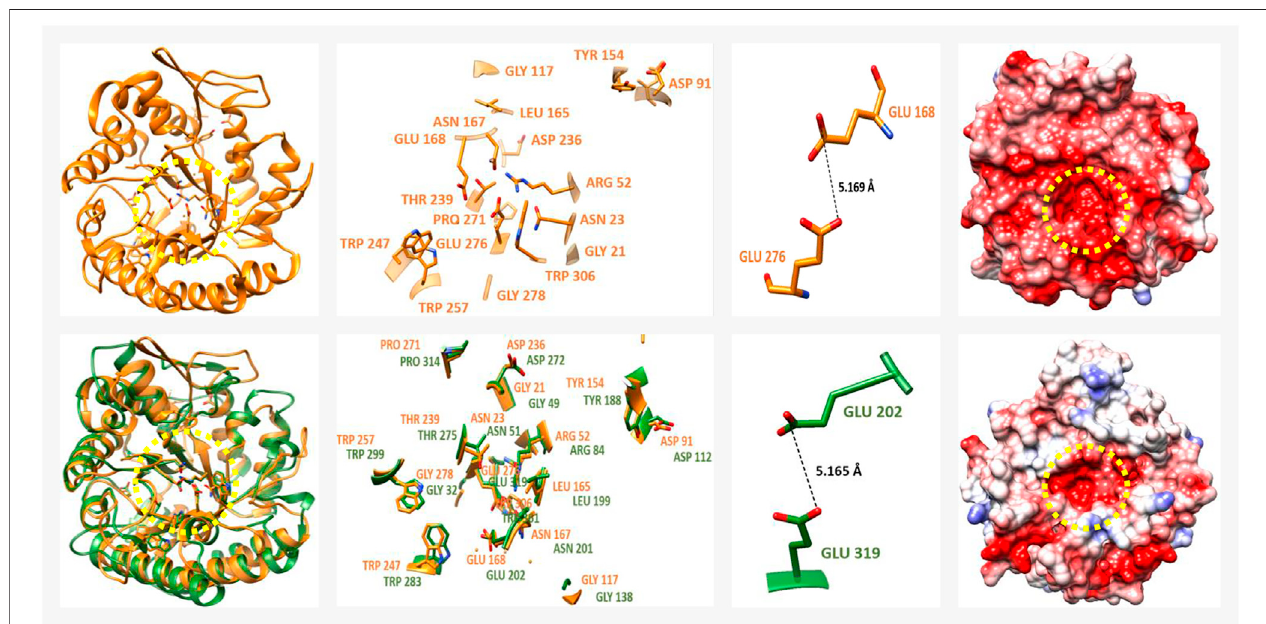
FIGURE 8 | 3D structure from an endo- β -1,4-mannanase (E β M-1,4) from Psittacanthus schiedeanus (enzyme member of GH5-7 family). From top to bottom, the E β M-1,4 from the phytopathogenic fungus Aspergillus niger BK01 (reference protein, PDB ID: 3WH9) followed by one of the modelled E β M-1,4 of the mistletoe P. schiedeanus . The E β M-1,4 from P. schiedeanus (UN045719, cyan) was superimposed with reference protein (red). From left to right (besides the 3D structures), a magni fi edimage withthehighly conserved amino acidresidues whichform theslot-likepocket from theactivesite isshown. Thisimageisfollowedbyanother with the estimated distance between the catalytic residues (two glutamic acid (Glu) residues) and fi nally, an electrostatic surface charge representation. The yellow dotted circles show the active site with a relatively low presence of positive charges. After alignment and the superimposing of the 3D modelled structures, the equivalent position of every amino acid residue into the active site is shown. E β M-1,4 3D protein model from P. schiedeanus were constructed in silico based on the homology to cited proteins and their solved crystal structure.